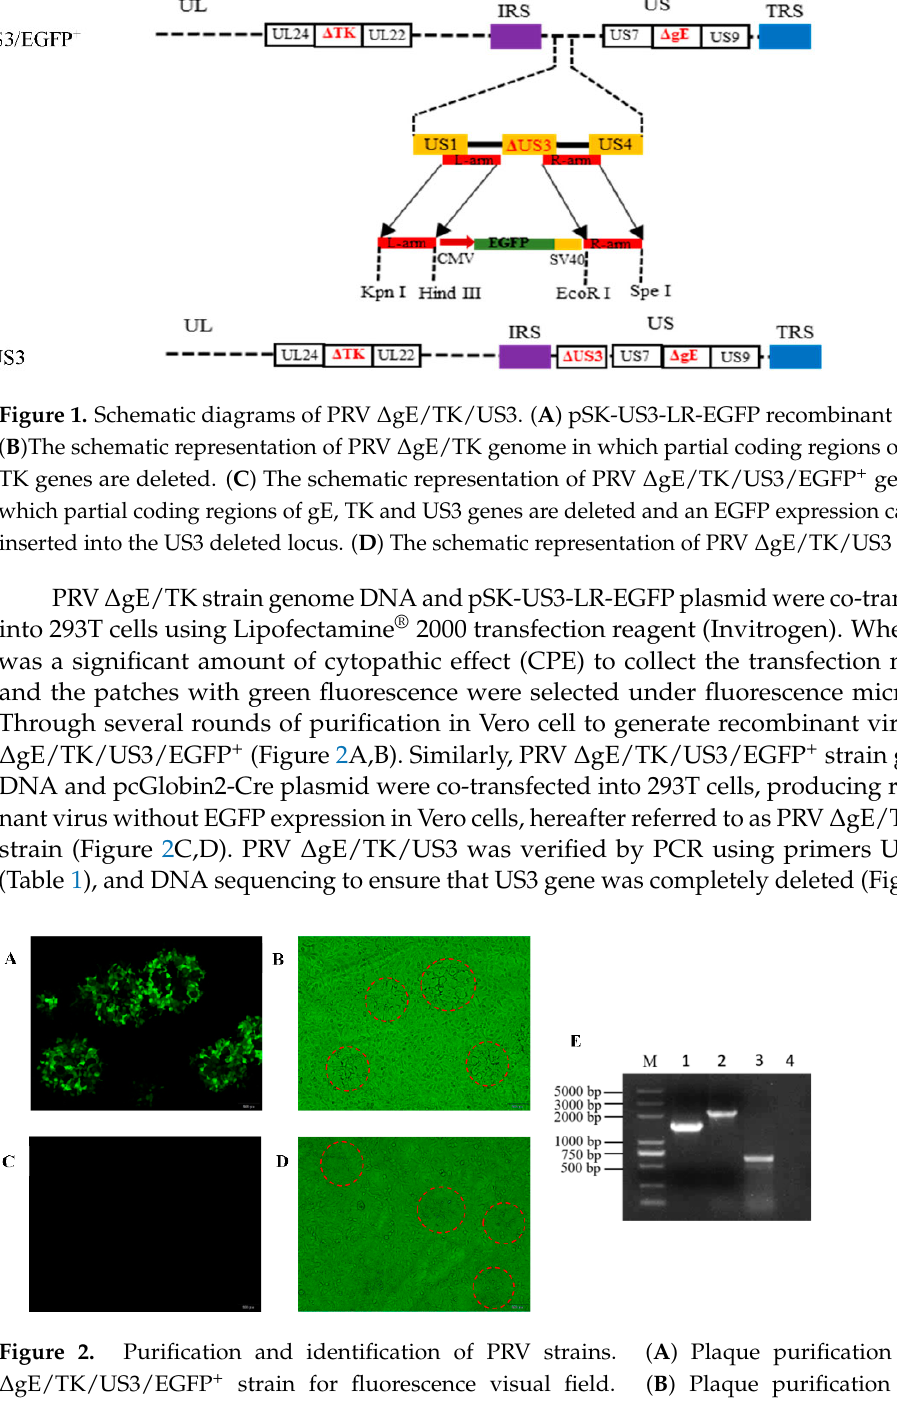
phate ‐ buffered saline (PBS) at 2 h post ‐ infection (hpi) and supplemented with DMEM containing 2% FBS. The cell supernatants were collected at 0, 6, 12, 18, 24, 30, 36, 42, and 48 h of different post ‐ infection time points, then virus titers were determined in 50% tissue culture infectious dose (TCID 50 ) following the Reed ‐ Muench method to establish growth curves. Three replicates were set up for each experiment. 2.4. Apoptosis To assess the effects of different PRV strains on apoptosis, Vero cells in 6 ‐ well plates were infected with PRV QYY2012, PRV Δ gE/TK or PRV Δ gE/TK/US3 at MOI of 0.01. Cells were collected and filtered to single cell suspensions at 24 hpi, all experiment samples were processed according to Annexin V ‐ FITC/PI apoptosis assay kit and examined using flow cytometry. Three replicates were set up for each experiment. 2.5. Swine Leukocyte Antigen Class I Molecule (SLA ‐ I) To detect the mRNA transcription levels of SLA ‐ I in ST cells infected with different PRV strains, ST cells in 6 ‐ well plates were infected with PRV QYY2012, PRV Δ gE/TK or PRV Δ gE/TK/US3 at MOI of 0.1, meanwhile, pUS3 plasmid was overexpressed in ST cells as control. The cells were lysed and collected at 6 h after infection or transfection. The RNA of cell lysate was obtained according to a total RNA extraction kit, and reverse ‐ tran ‐ scribed into complementary DNA (cDNA). Using cDNA as a template, the levels of SLA ‐ I mRNA transcription in cells were detected by real ‐ time quantitative PCR (RT ‐ qPCR) us ‐ ing primers SLA ‐ I qF/R (Table 1). Relative expression level was ascertained after normal ‐ ization against β‐ actin as an internal reference and calculated by 2 −∆∆ Ct . Three replicates were set up for each experiment. 2.6. Pro ‐ Inflammatory Cytokines BALB/c mice were randomly divided into 4 groups ( n = 8/group). Mice were intra ‐ muscularly inoculated with 10 6 TCID 50 PRV QYY2012, PRV Δ gE/TK or PRV Δ gE/TK/US3,